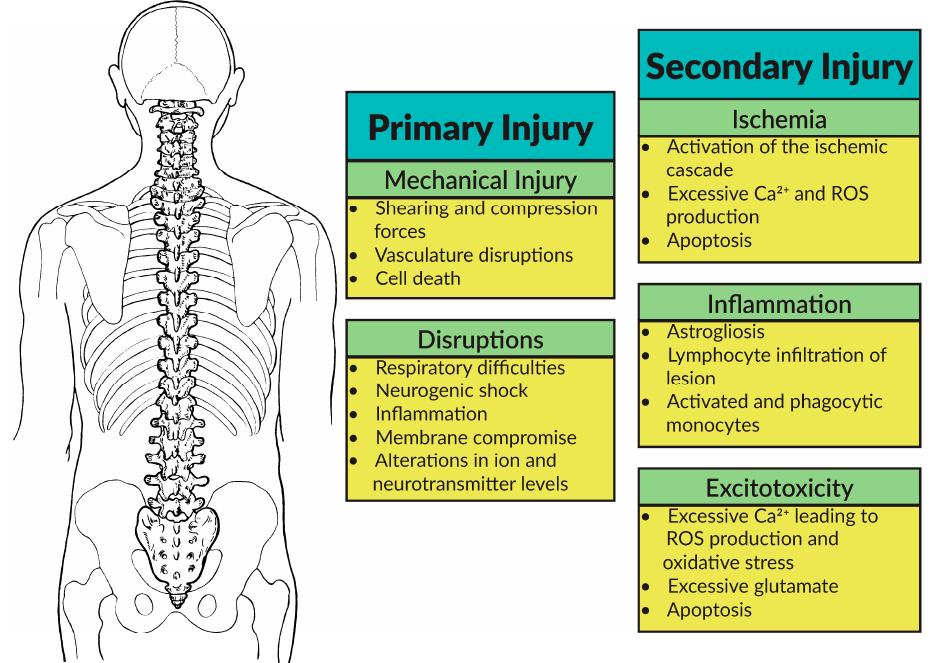
Figure 2. The Spinal Cord Injury (SCI) Cascade is comprised of both a primary and secondary component that ultimately results in ischemia, inflammation, and reactive oxygen species (ROS)-based excitotoxicity.